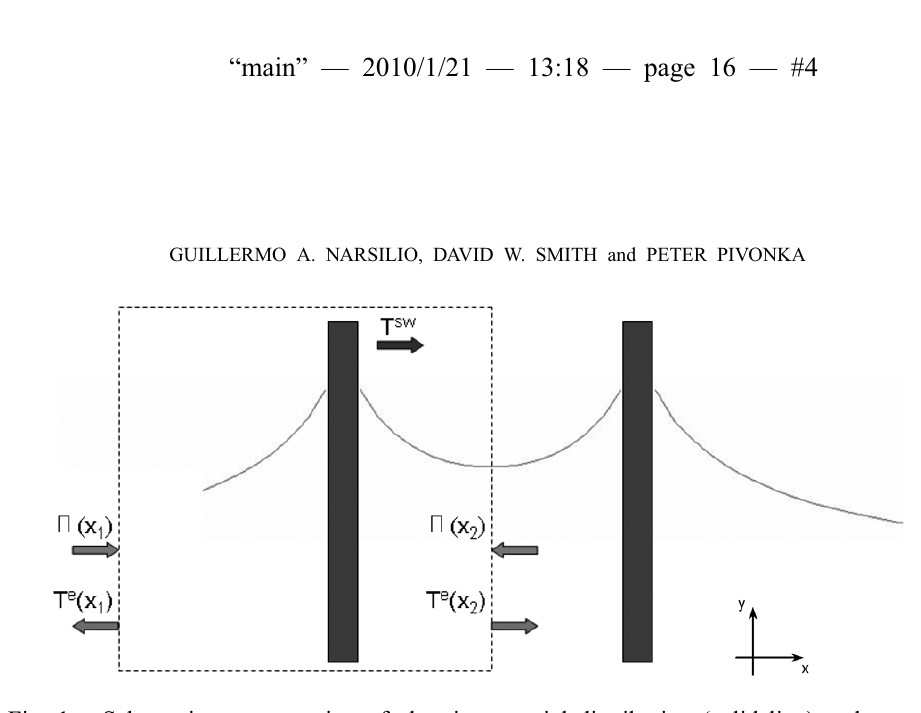
Fig. 1 – Schematic representation of electric potential distribution (solid line) and stresses acting on a ‘tensor box’ (dotted line) with left and right edges at x 1 and x 2 positions